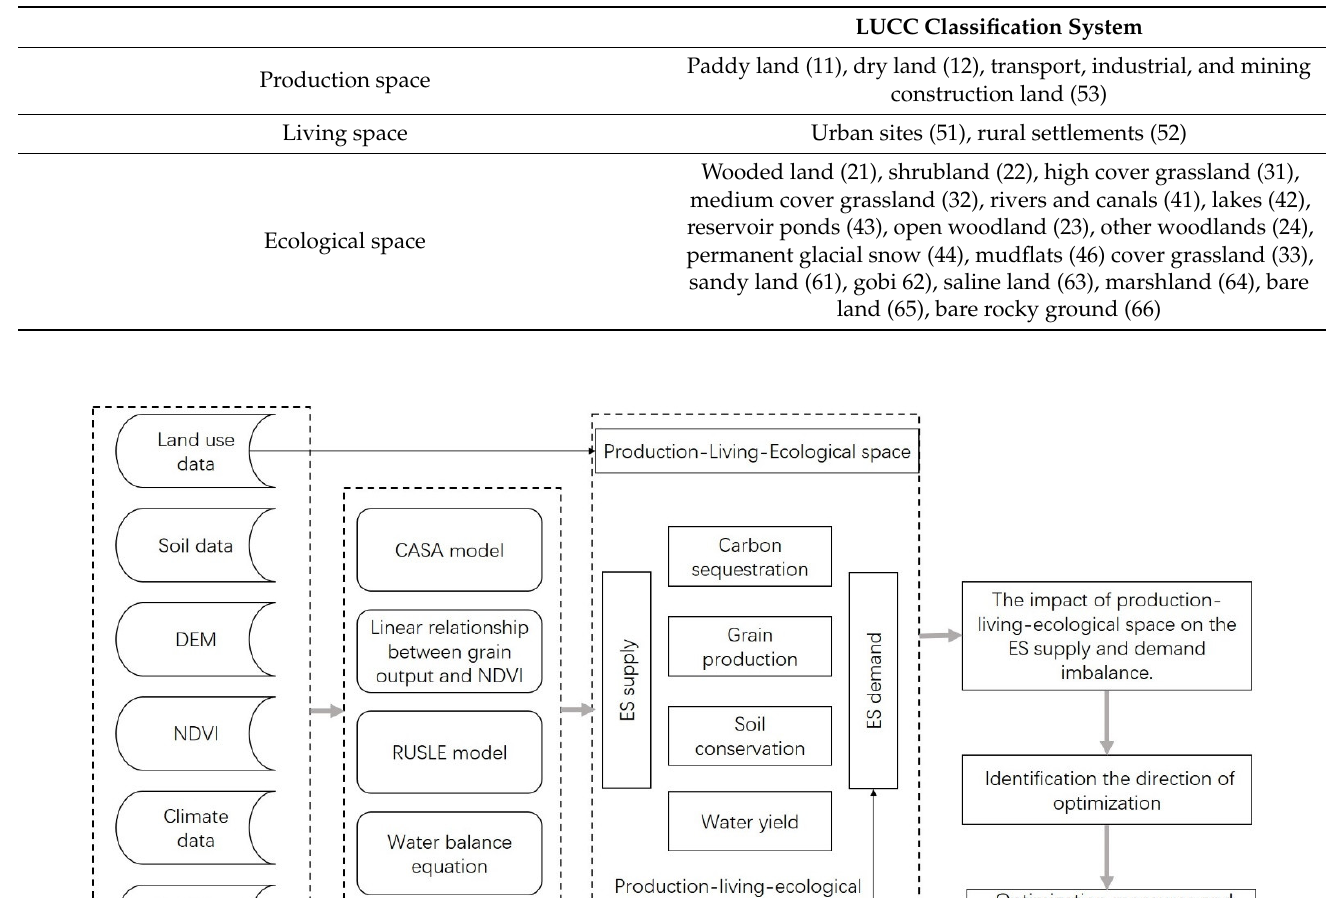
Table 1. Production-living-ecological space classification in the Yellow River Basin.